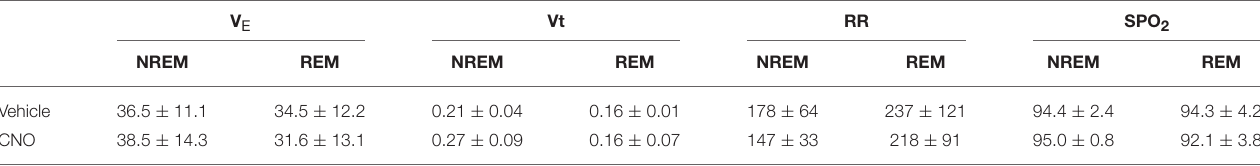
TABLE 3 | Physiology of non-flow limited breathing in C57BL/6J mice, which underwent sleep studies after vehicle (saline) and clozapine-N-oxide (CNO)